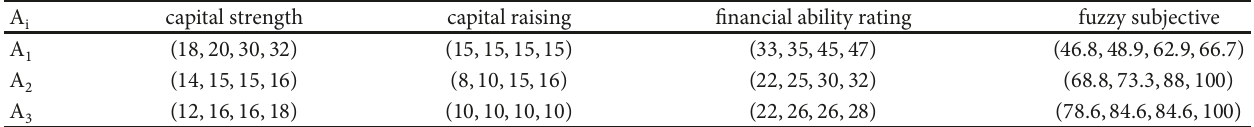
Table 7: Evaluation of decision makers under objective evaluation attributes and set evaluation.